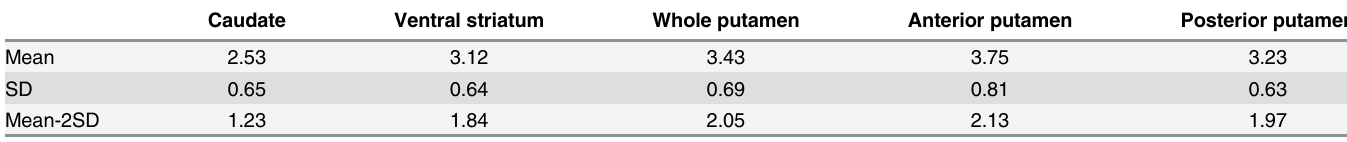
Table 1. Normal data of 18 F-FP-CIT uptake. Mean value and standard deviation (SD) of each striatal subregions were from 68 healthy controls. Patient who showed uptake lower than mean-2SD in any subregion was excluded from this study. Caudate Ventral striatum Whole putamen Anterior putamen Posterior